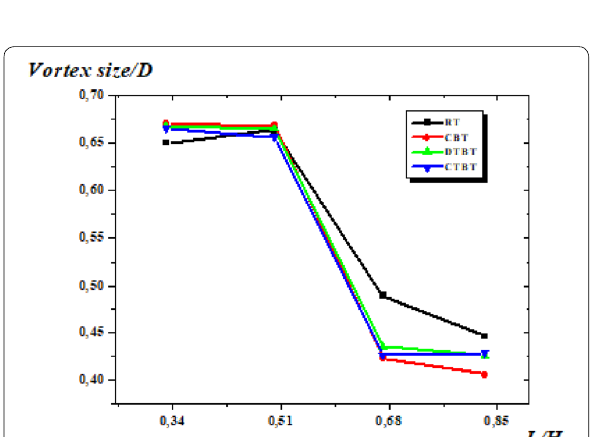
Figure 15 Vortex size for different agitator’s types with various baffles heights, Re